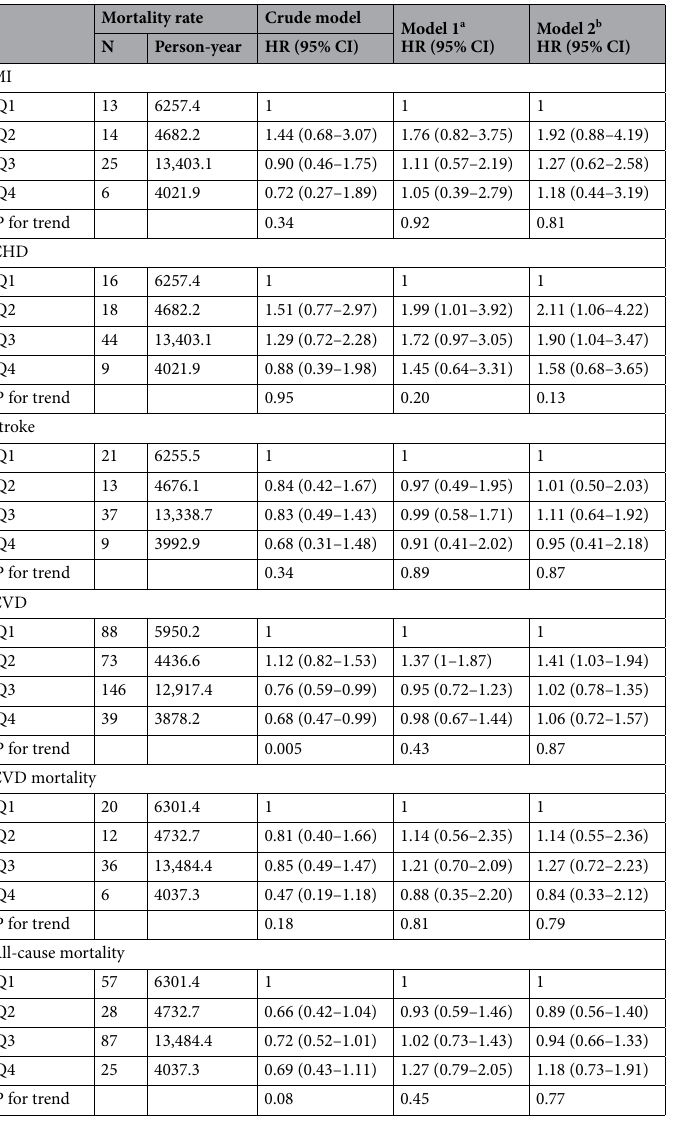
Table 9. Multiple adjusted relative risk of global dietary index in cardiovascular diseases among women. a Adjusted for age (year). b Additionally adjusted for education (illiterate/primary school/more than primary school), residency (urban/rural), smoking status (never/past/current smoker), daily physical activity (METs- min/day), aspirin use (yes/no), post menopause in women (yes/no), body mass index (kg/m 2 ), hypertension (yes/no) and diabetes mellitus